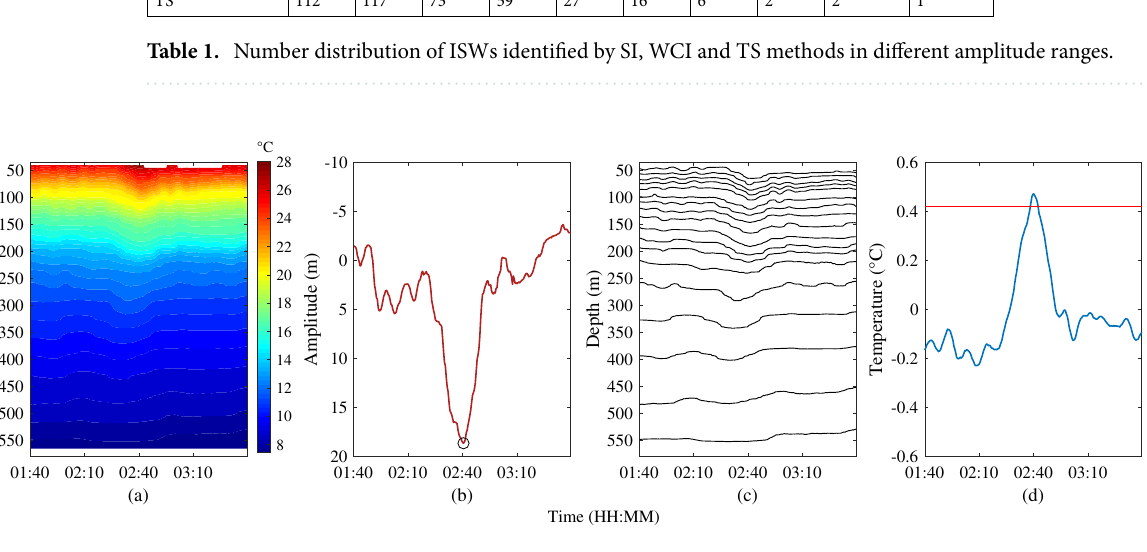
Figure 12. A case of identifying an ISW with an amplitude more than 20 m. ( a ) Spatio-temporal distribution of temperature on August 26, 2018. ( b ) ISW identified by SI method, the downward spike-like fluctuation (small black circle) is same as Fig. 4. ( c ) ISW identified by WCI method. ( d ) ISW identified by TS method, the red line is the identification index with a value of 0.42 corresponding to 20 m